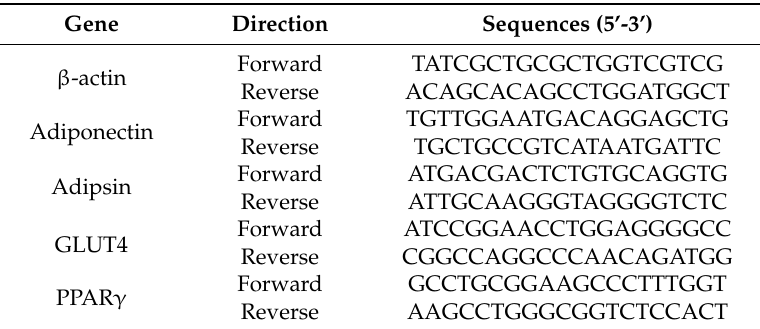
Table 1. Primer sequences used for